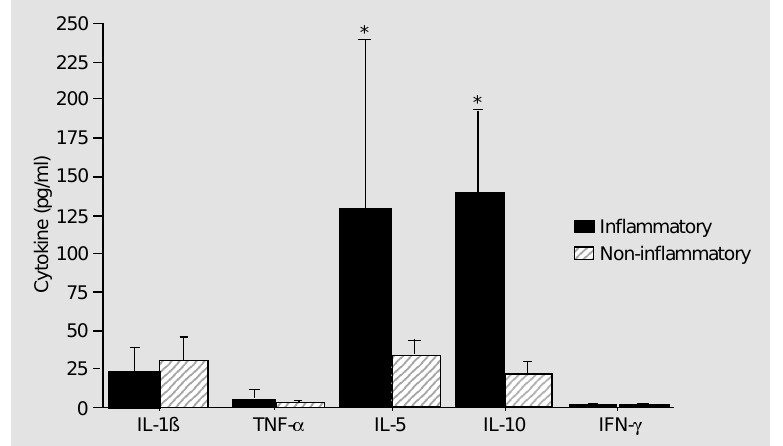
Figure 3 - Cytokine levels in CSF from 8 patients with active NCC with inflammatory CSF (filled bars) and from 14 NCC patients with non-inflammatory (striped bars) CSF based on protein concentrations and cell counts. Statistical analysis was performed on log-trans- formed cytokine levels. *P<0.05 compared to NCC patients with non-inflammatory